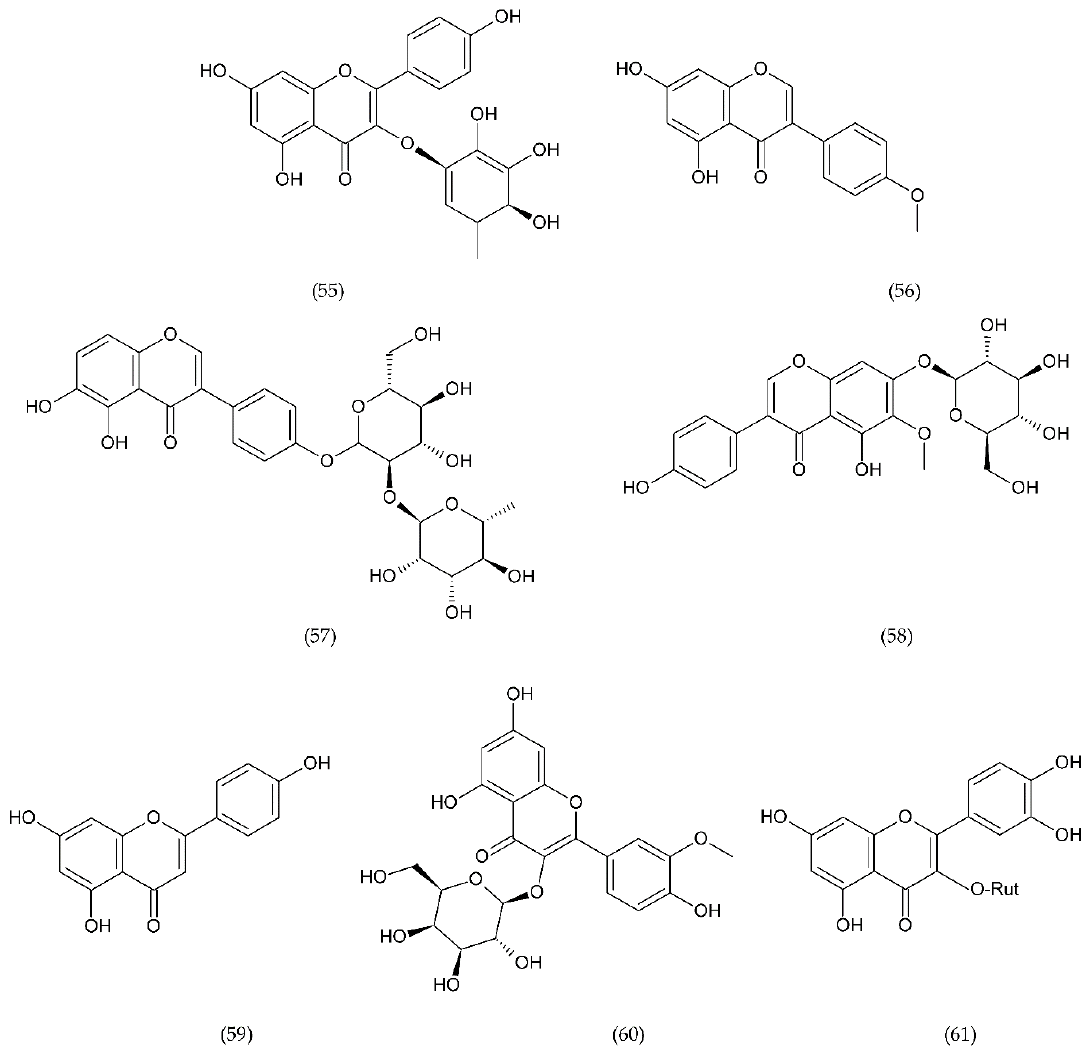
Figure 18. Chemical structure of afzelin (55), biochanine A (56), sophorabioside (57), tatectoridin (58), apigenin (59), isorhamnetin glucosides (60), and rutin (61).